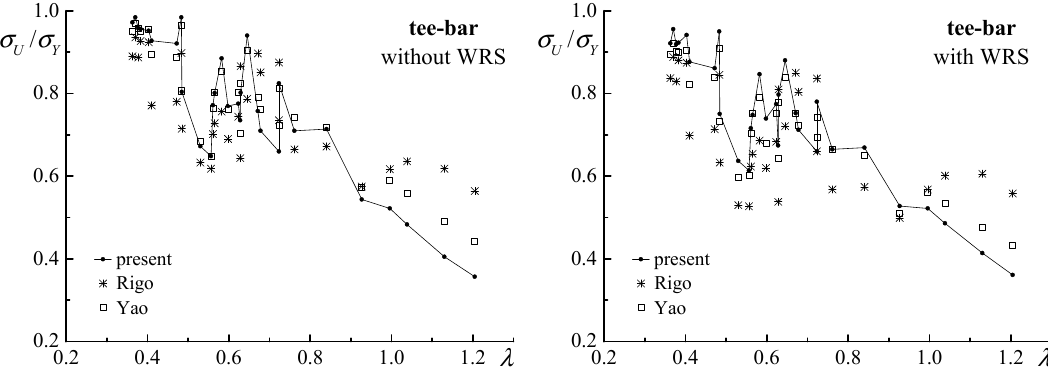
Figure 6. Results for the ultimate strength of angle-bar stiffened plate versus column slenderness ratio compared with the ISSC’2000 Report [11].